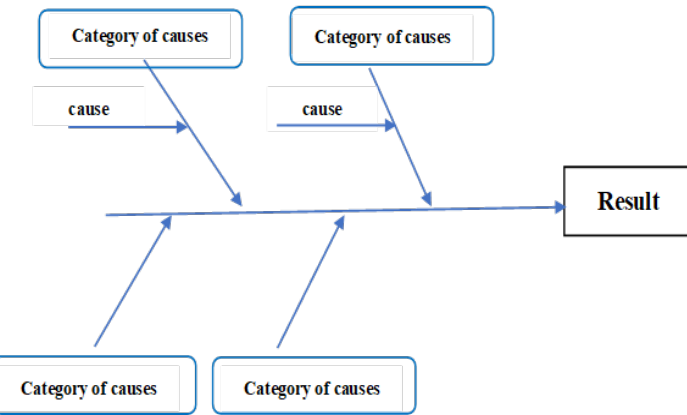
Figure 2. Outline of the Ishikawa diagram. Own study based on [63].